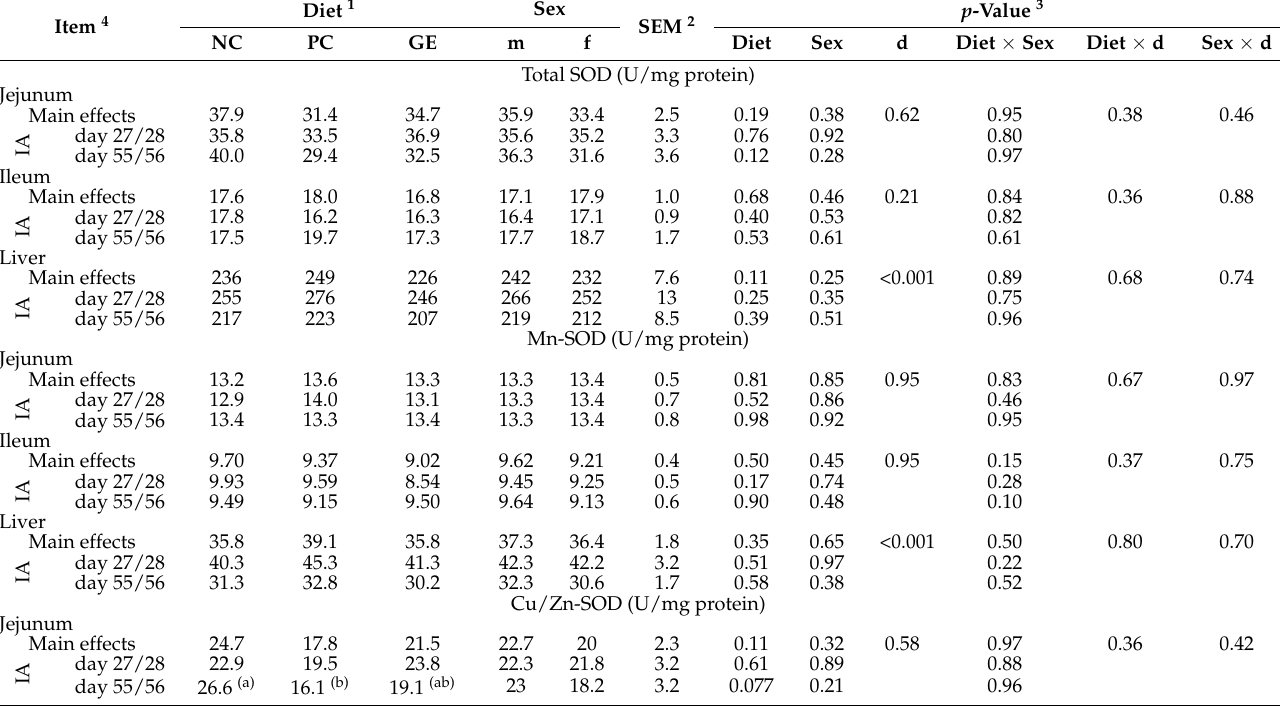
Table 5. Effect of dietary GE supplementation on superoxide dismutase activity from the intestinal tissue and liver of the weaning piglets compared to NC and